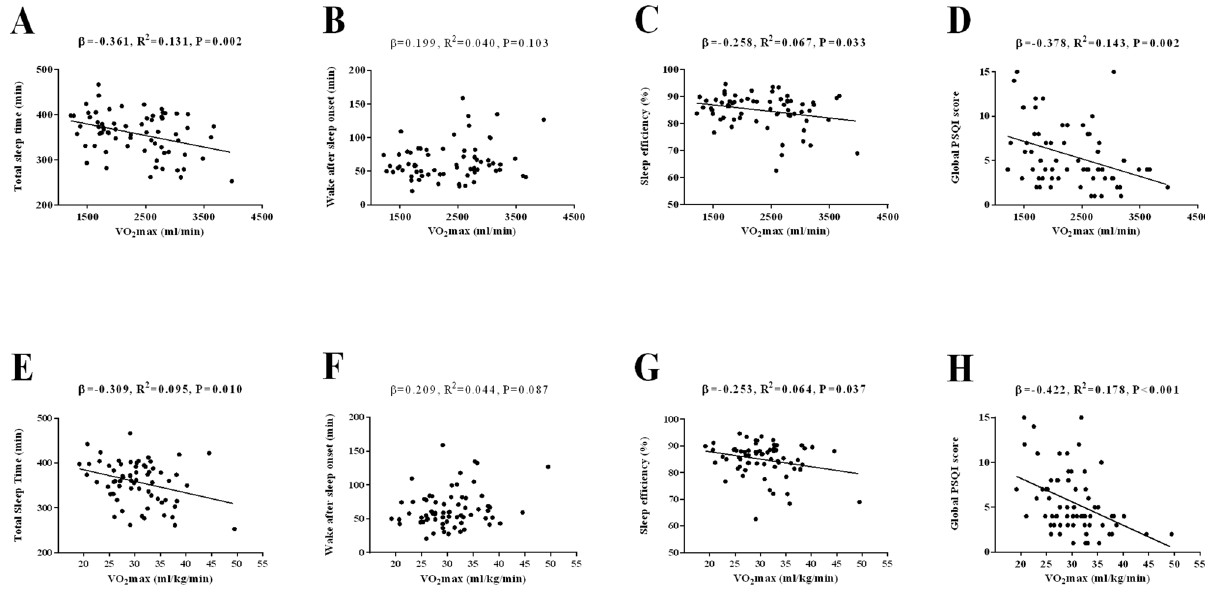
Figure 3. Association of cardiorespiratory fitness with both objective and subjective sleep quantity and quality in sedentary middle-aged adults. β (standardized regression coefficient), R 2 , and P from a simple linear regression analysis. Significant P values (≤ 0.05) are in bold. PSQI Pittsburgh Sleep Quality